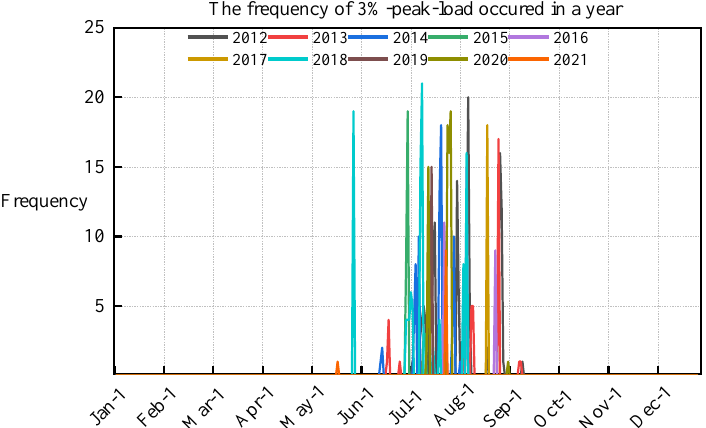
Figure 2. Frequency of 3% peak load occurring in a year from 2012 to 2021.